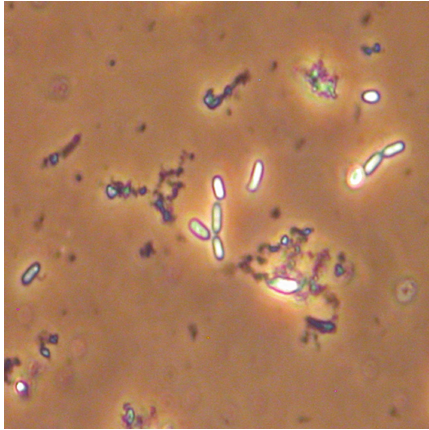
Figure 2: Image of spores classified as Nosema by phase-contrast light microscopy. The smaller elongate spores measure 4.5 × 2.0 microns. PCR with the Nbombi-SSU-Jfl/Jrl primer pair did not produce a detectable amplicon for this